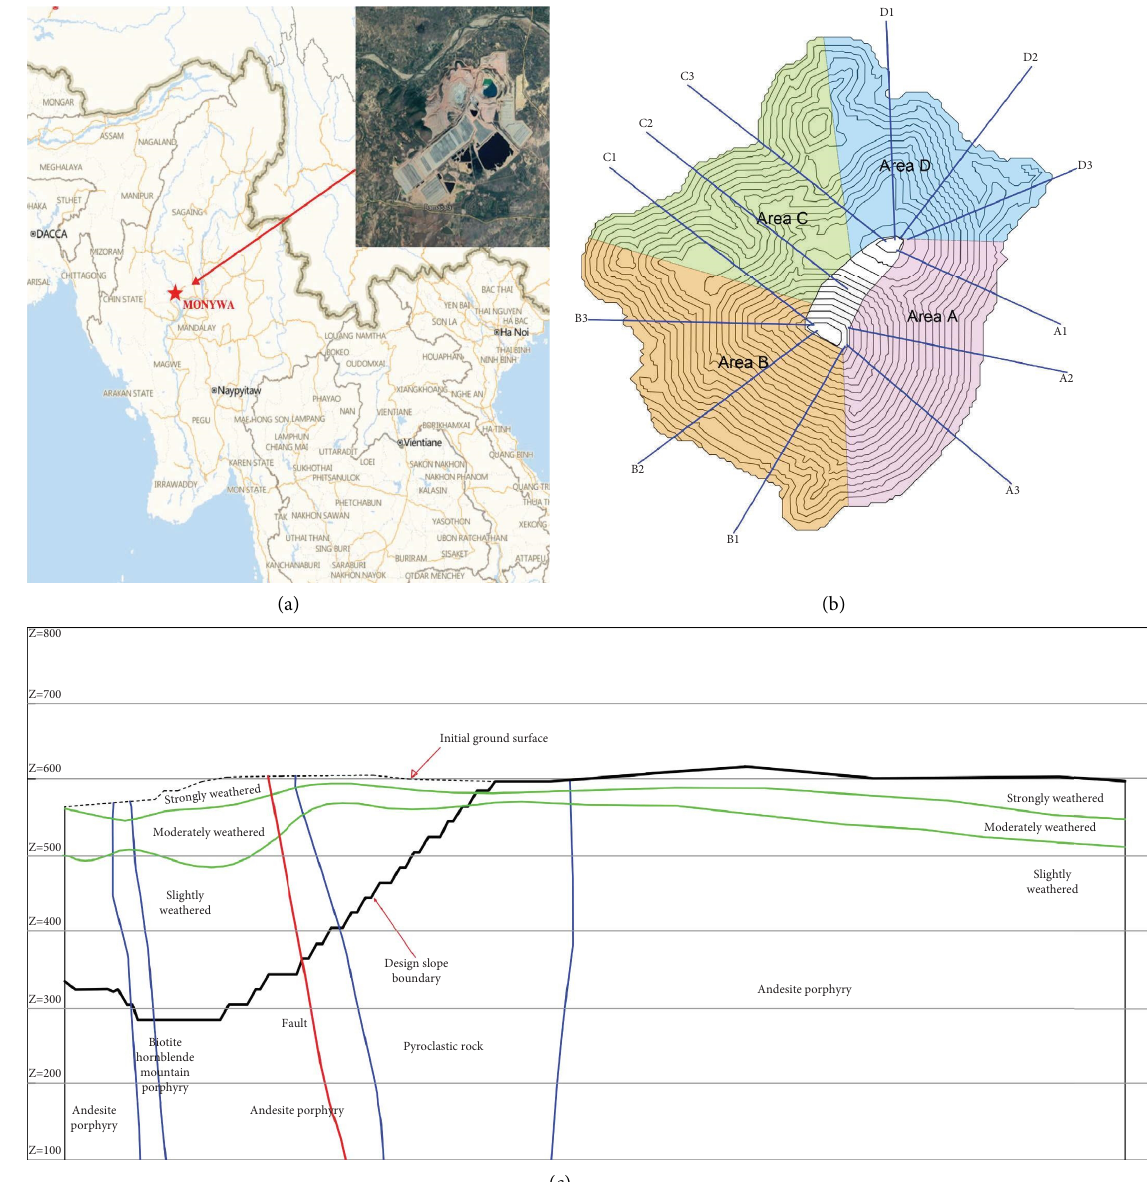
Figure 3: Illustration of the K open-pit mine in Myanmar. (a) Location. (b) Engineering geological division. (c) A 1 engineering geological